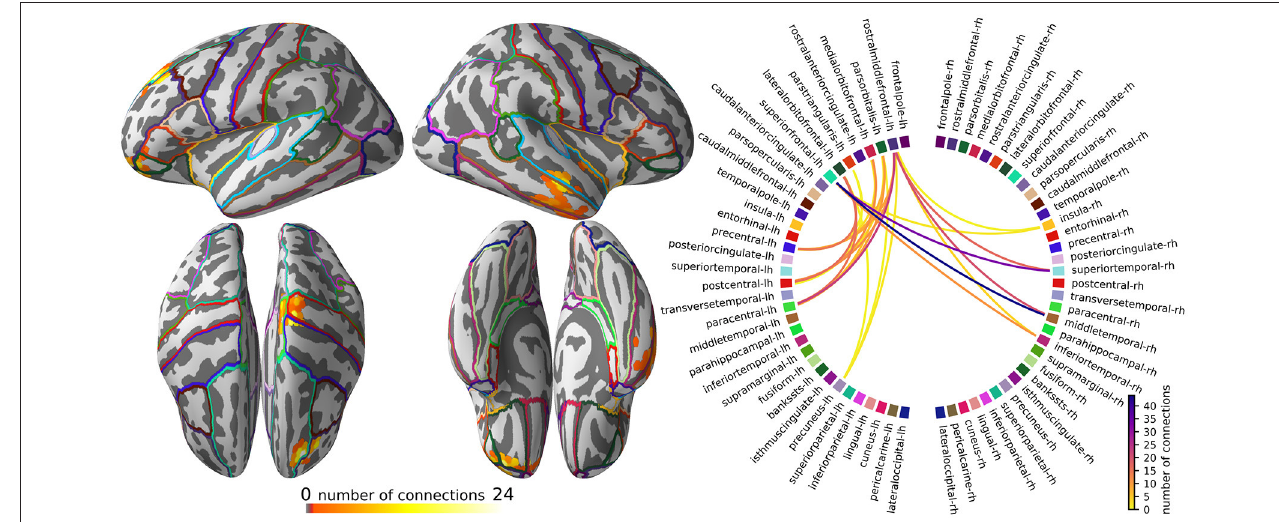
FIGURE 4 | The subnetwork of the all-to-all connectivity network that shows the most robust changes across the experimental conditions. (Left) Degree map showing, for each source point, the percentage of connections, out of all possible connections, that survived the statistical threshold and clustering operations. (Right) Circular connectogram showing the number of connections between each parcel. Parcels were defined using the “aparc” anatomical brain atlas, provided by